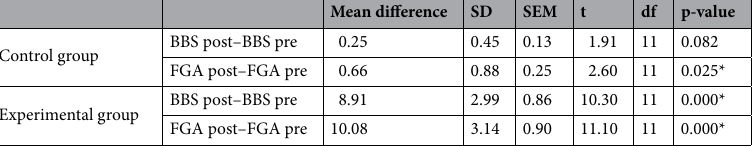
Table 2. With-in-group comparison results for dependent variables in both groups. SD: standard deviation; SEM: standard error mean; BBS: Berg Balance Scale; FGA: functional gait assessment. *Significant.